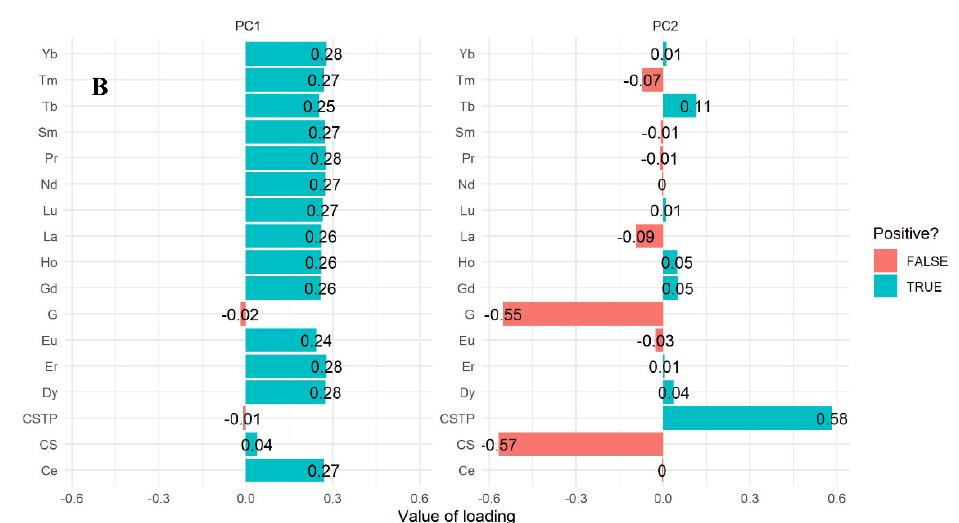
Figure 1. Principal component analysis biplot ( A ) and loadings ( B ) for the relationship between rare earth elements in AlWajah and Jazan mangrove ecosystems. G—Gravel, CSTP—Clay and Silt particles, CS—Coarse sandy.